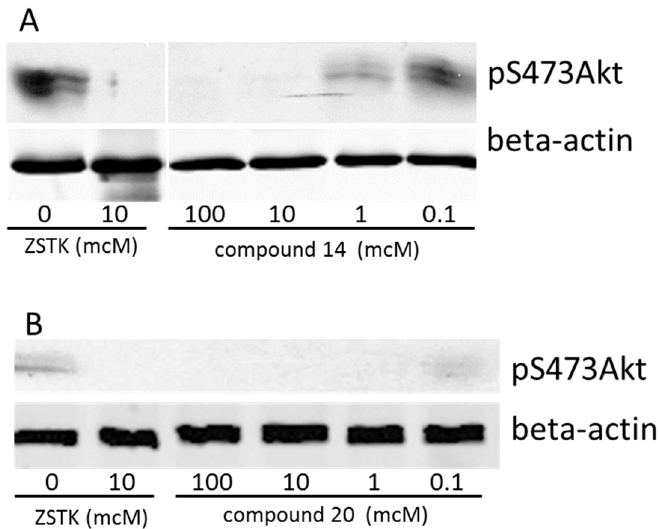
Figure 1. Representative Western blots of S473AKT phosphorylation in C4-2 prostate cancer cells. ( A ) C4-2 cells were treated with ZSTK474 (10 µM) or compound 14 (100, 10, 1, 0.1 µM); ( B ) C4-2 cells were treated with ZSTK474 (10 µM) or compound 20 (100, 10, 1, 0.1 µM). Equal loading is controlled by probing Western blot for beta-actin.